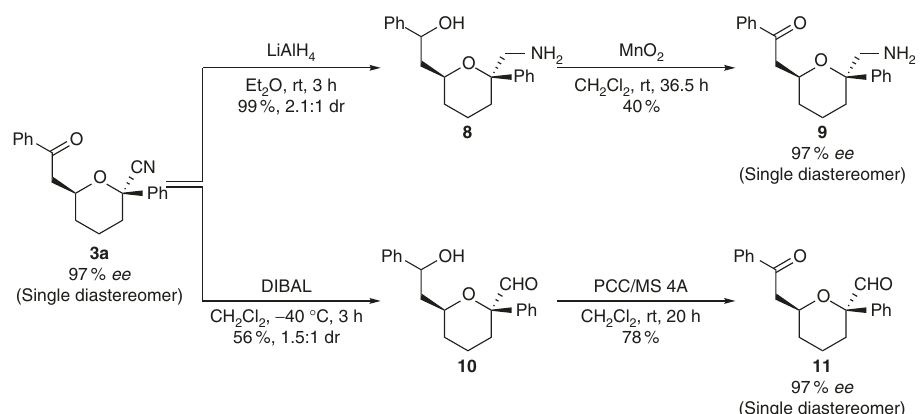
Fig. 5 Transformations of the cyano group in product 3a . Synthesis of 8 : 3a (0.10 mmol) was treated with lithium aluminium hydride (0.50 mmol) in Et 2 O (1.0 ml). Synthesis of 9 : 8 (0.10 mmol) was treated with manganese dioxide (1.0 mmol) in CH 2 Cl 2 (2.0 ml). Synthesis of 10 : 3a (0.10 mmol) was treated with diisobutylaluminium hydride (0.40 mmol) in CH 2 Cl 2 (1.0 ml). Synthesis of 11 : 10 (0.056 mmol) was treated with pyridinium chlorochromate (0.17 mmol) in CH 2 Cl 2 (2.0